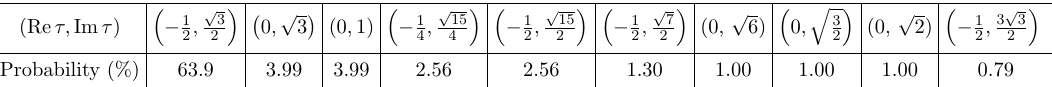
Table 4 . Approximated probabilities of the stable vacua as functions of (Re (cid:28); Im (cid:28) ) shown in table 3, predicted by the statistical